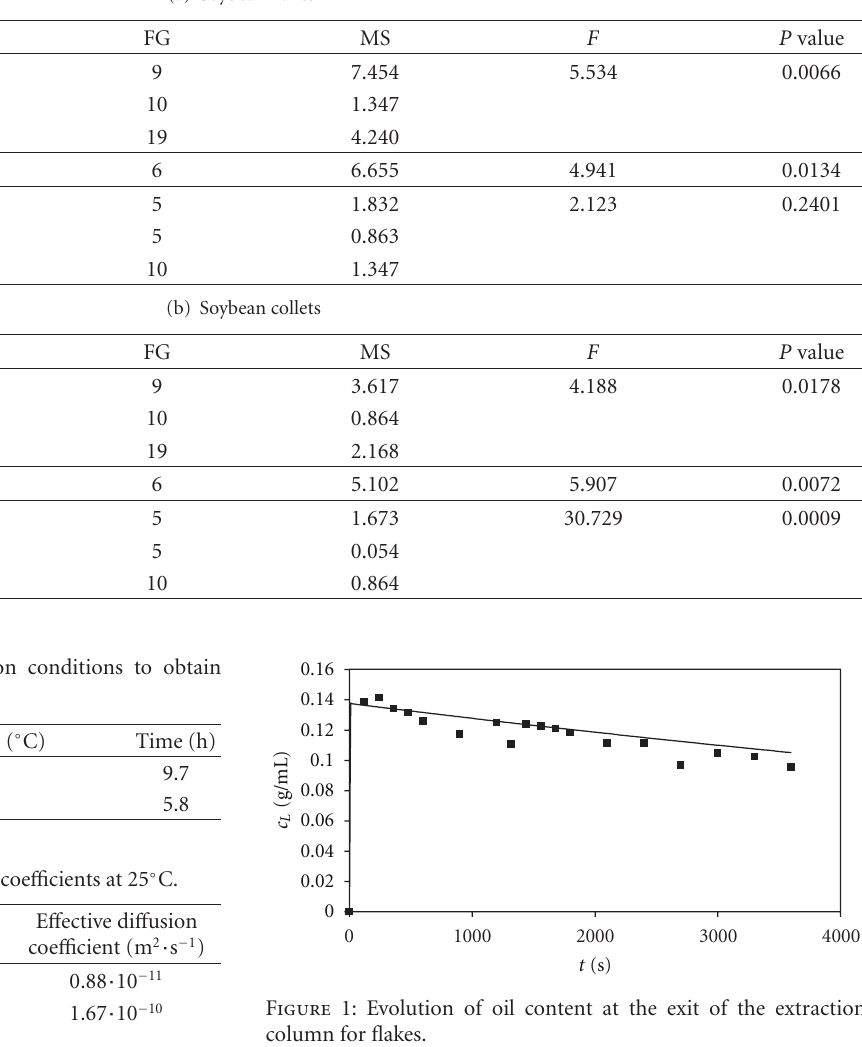
Table 3: ANOVA results for yield optimization in oil.